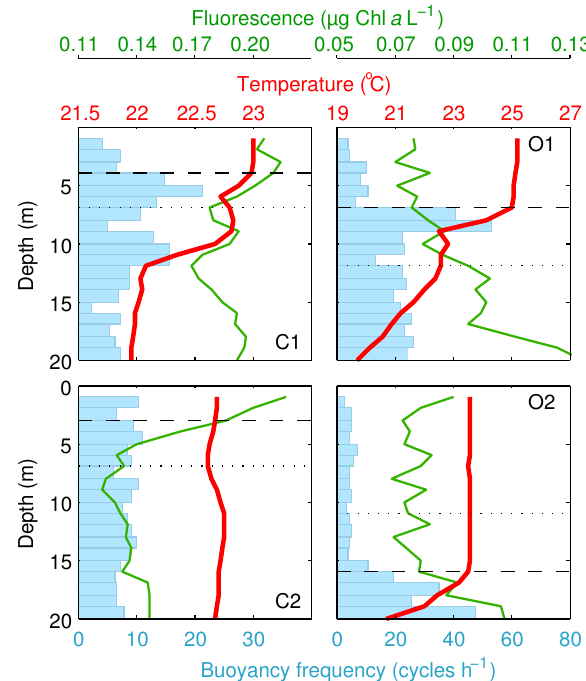
Fig. 2. Vertical profiles of temperature, Chl a fluorescence and buoyancy (Brunt–Väisälä) frequency at the time of sampling in the four experiments. The horizontal dashed line indicates the depth of the mixing layer and the dotted line the 10% penetration of 320nm radiation (see also Table